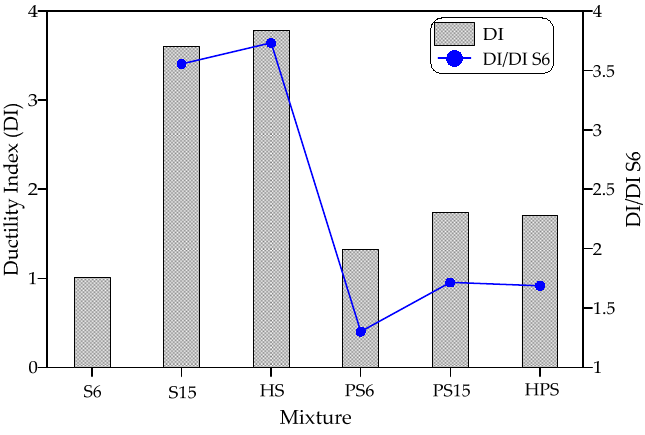
Figure 7. Impact ductility of all mixtures.